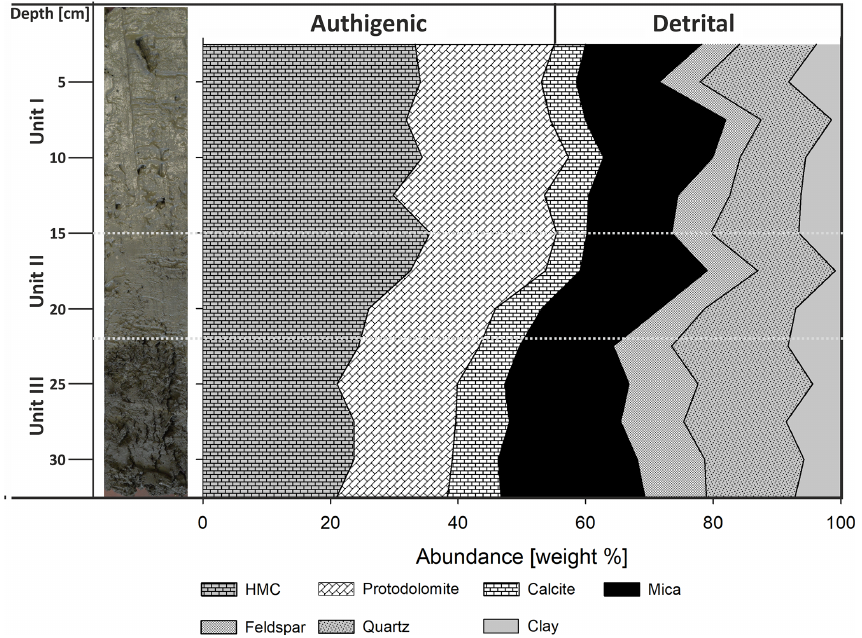
Figure 7. Core LN-K04 with the defined units I–III (left) and mineral quantities estimated from main peak heights (right; HMC: high- magnesium calcite). The changes of mineral abundances coincide with unit boundaries.